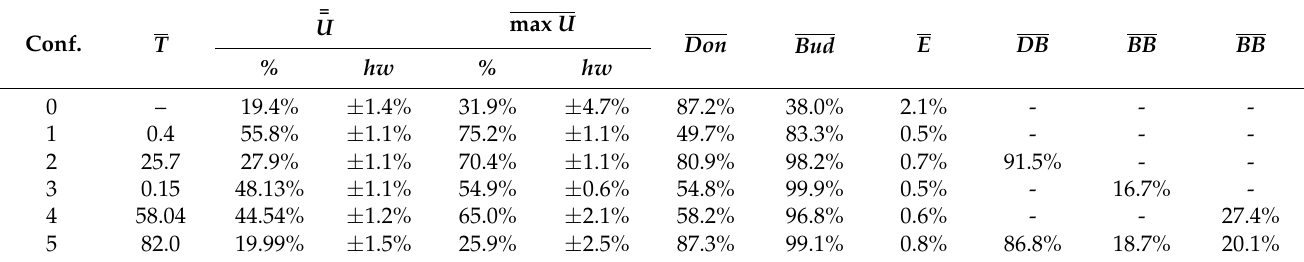
Table 7. Aggregated results produced by each configuration to the 320